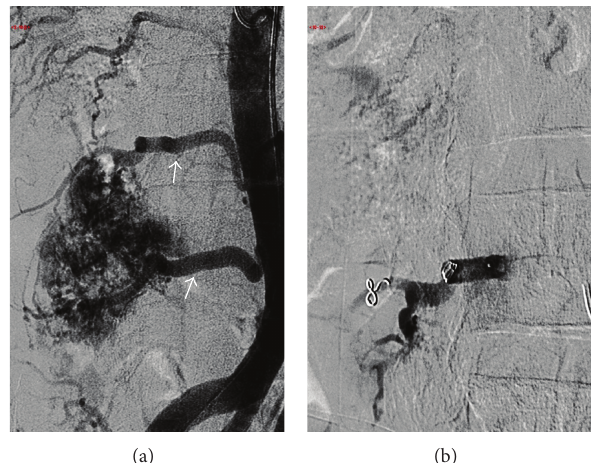
Figure 5: Frontal angiographic images preembolization (a) shows two large L3 and L4 lumbar arteries (white arrows) supplying the hypervascular tumour. Postembolisation with particles (150–250 microns) and fiber coils (b) shows near complete obliteration of the tumor